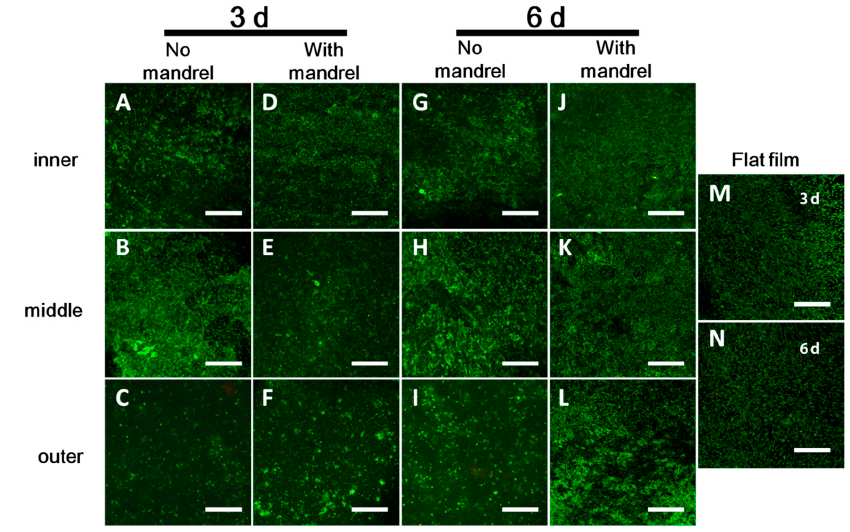
Figure 4. Cell viability at 3 ( A )–( F ) and 6 ( G )–( L ) days with ( D )–( F ), ( J )–( L ) and without ( A )–( C ), ( G )– ( I ) mandrel. ( A ), ( D ), ( G ), ( J ) inner layer. ( B ), ( E ), ( H ), ( K ) middle layer. ( C ), ( F ), ( I ), ( L ) outer layer. ( M ) cell viability at 3-d culture on flat film ( N ) cell viability at 3-d culture on flat film. Green: live cells. Red: dead cells. The model cell used is C2C12 cell. Each image is chosen randomly as the representative image in corresponding layers. Scale bars: 200 μ m.